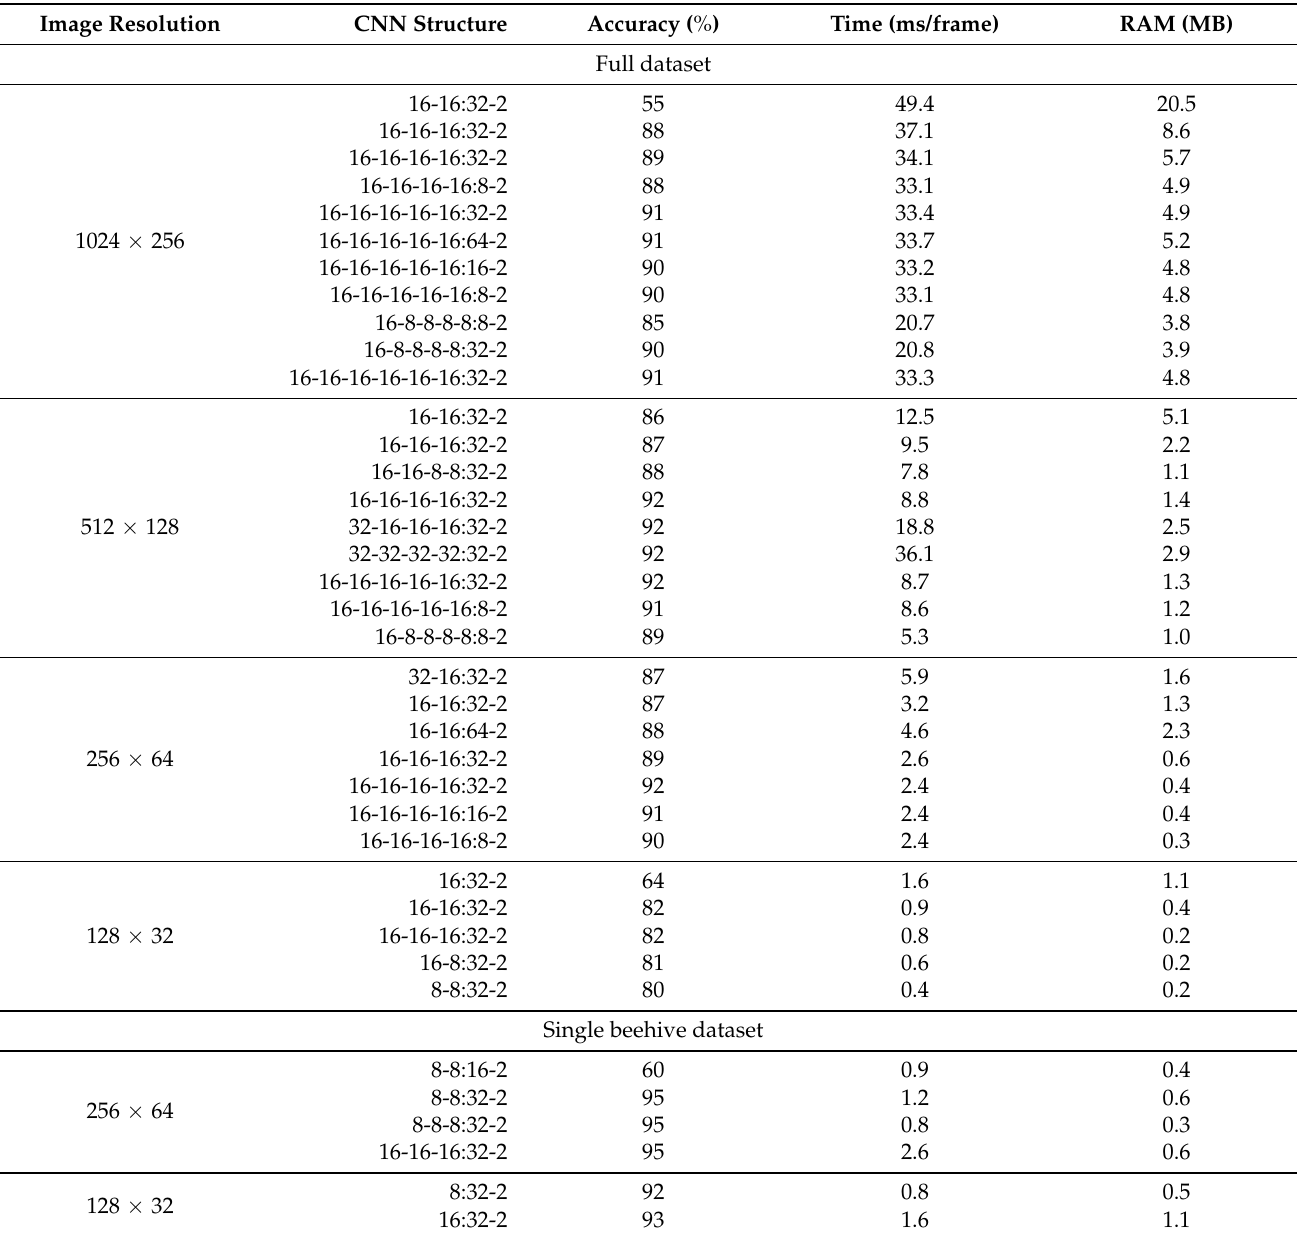
Table 3. Classification accuracy, time per frame, and memory consumption depending on the image resolution and CNN